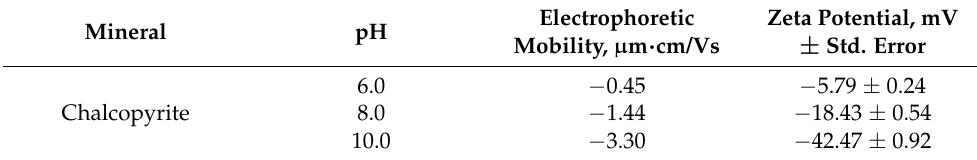
Table 4. Electrophoretic mobility and zeta potential and for the